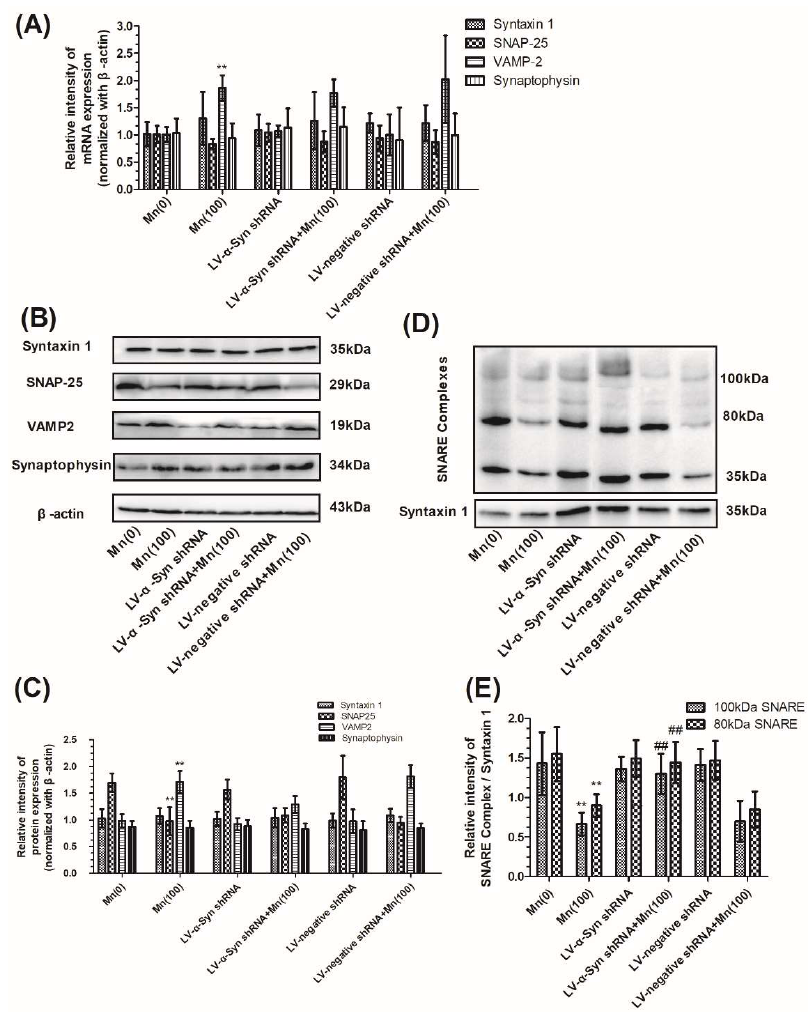
Figure 5. α -Syn shRNA did not change expression of VAMP-2 proteins, but promoted the formation of SNARE complex during Mn exposure. After normal and transfected cells were exposed to 100 µ M of Mn, the mRNA and protein expression of syntaxin 1, SNAP-25, VAMP-2, and synaptophysin was determined. ( A ) The mRNA expression of syntaxin 1, SNAP-25, VAMP-2, and synaptophysin normalized with β -actin. ( B ) The protein products of syntaxin 1, SNAP-25, VAMP-2, synaptophysin, and β -actin. ( C ) Semi-quantitative analysis of the protein expression of syntaxin 1, SNAP-25, VAMP-2, and synaptophysin normalized with β -actin. ( D ) The protein products of the SNARE complex. ( E ) Semi-quantitative analysis of the protein expression of SNARE complex protein normalized with syntaxin 1. Data represent mean ± standard deviation, n = 4. ** p < 0.01 indicates significant differences from the controls; ## p <0.01 indicates significant differences from the 100 μΜ Mn-treated group.